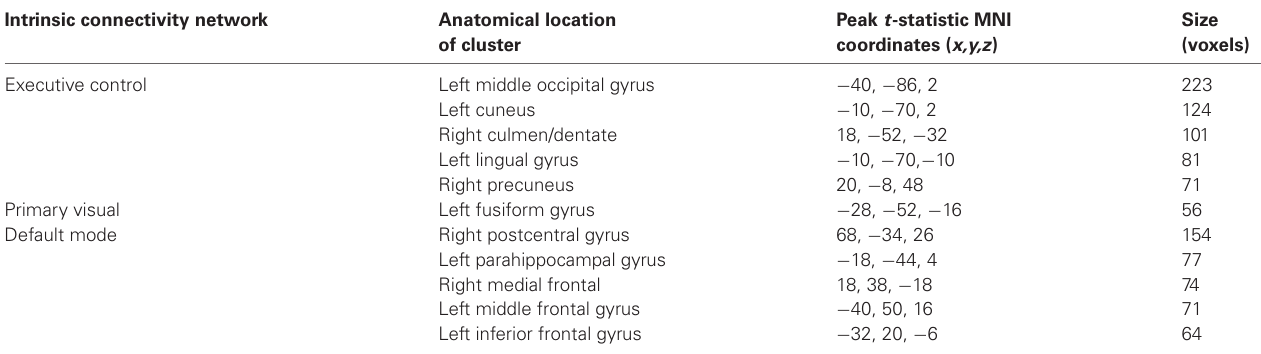
Table 2 | Location of significant connectivity differences